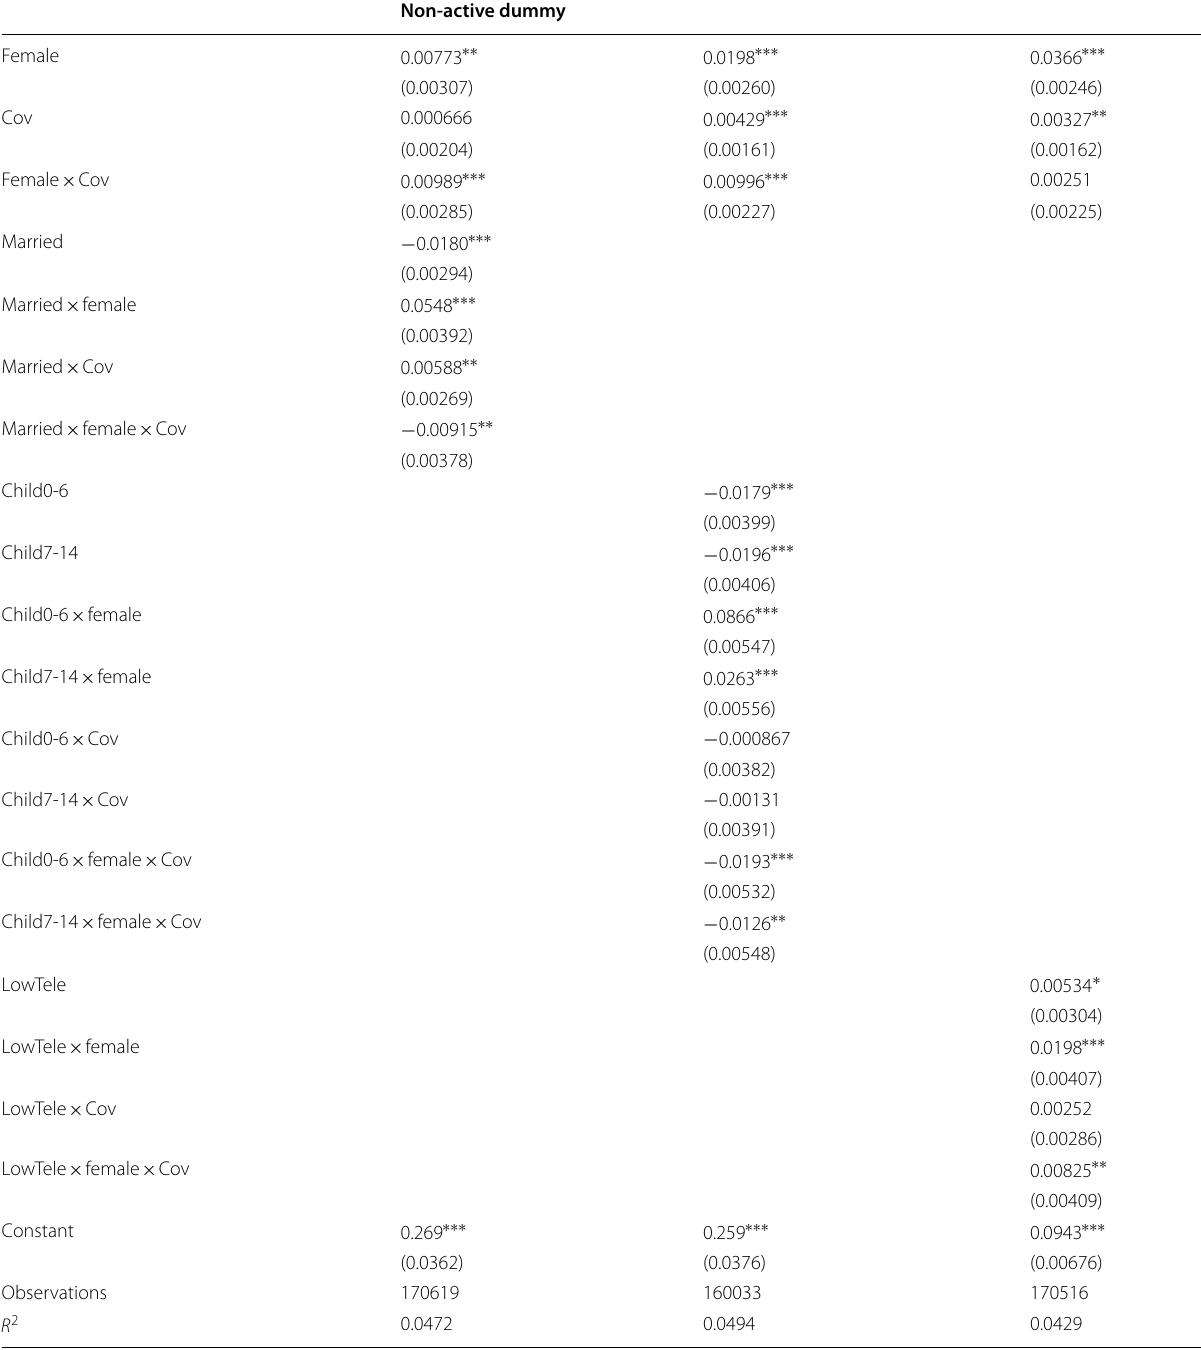
Table 13 Robustness: replacing COVID stringency index by COVID